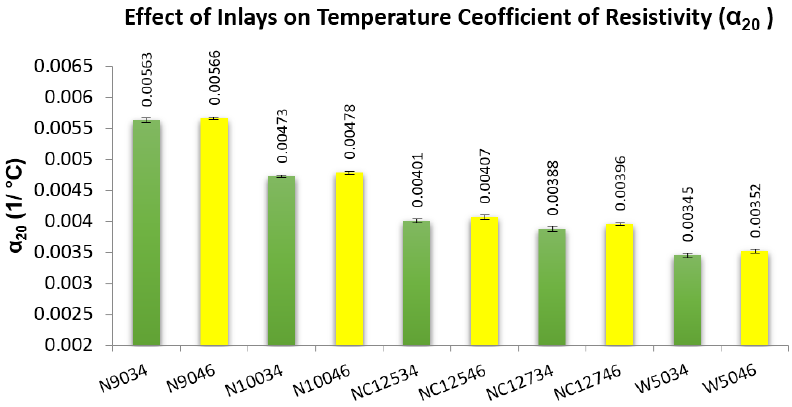
Figure 19. Effect of Inlays on Temperature Coefficient of Resistivity.